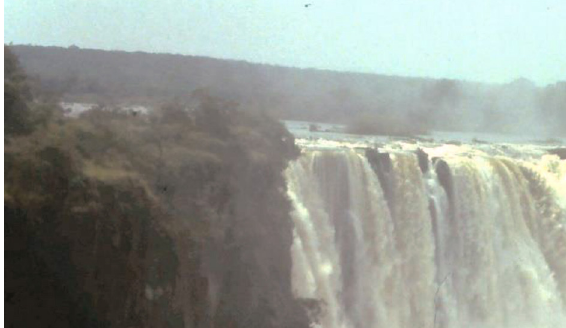
Fig. 4. The Victoria Falls from the Zimbabwe side. Photo: August